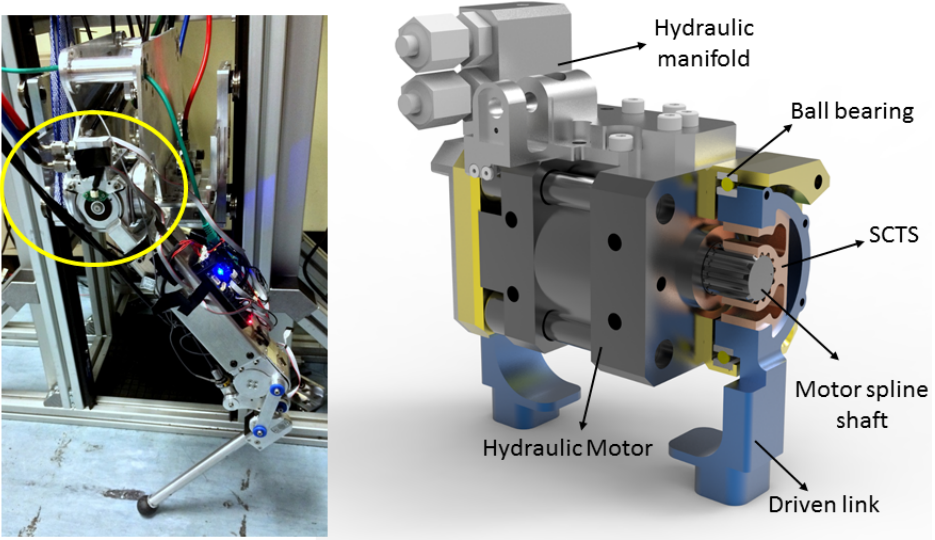
Figure 22. ( left ) Picture of MiniHyQ single leg where hip joint encircled in yellow; ( right ) CAD model of MiniHyQ hip joint’s hydraulic motor, where SCTS is fitted into motor spline shaft and its outer keyholes are locked with lower driven